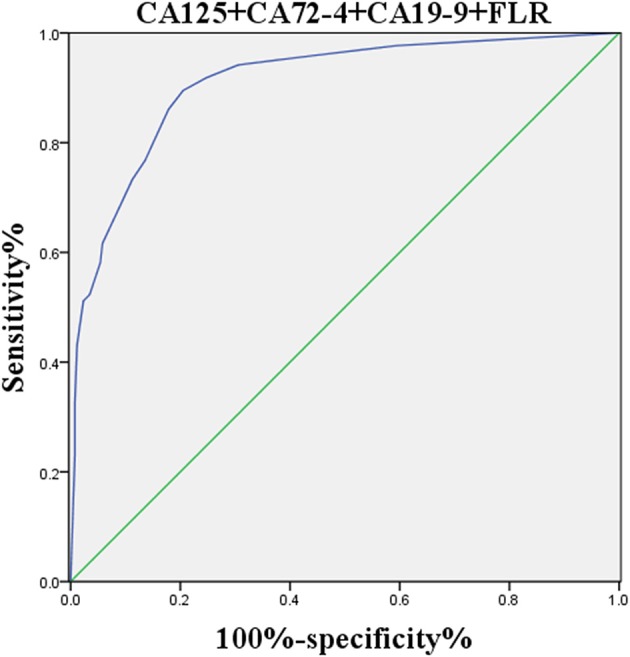
ROC curve of independent risk factors of PD in GC.